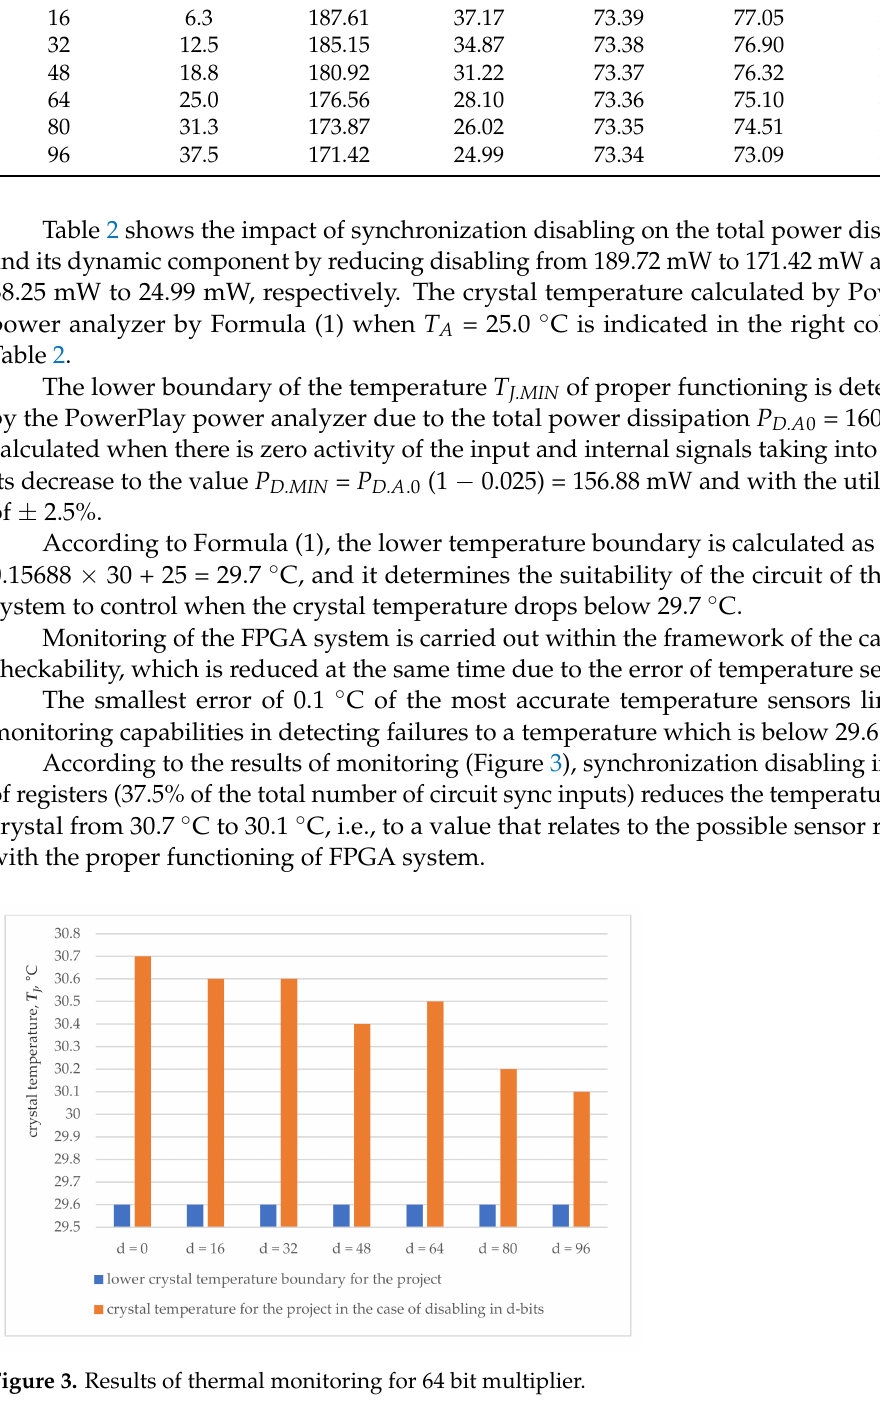
Figure 3. Results of thermal monitoring for 64 bit